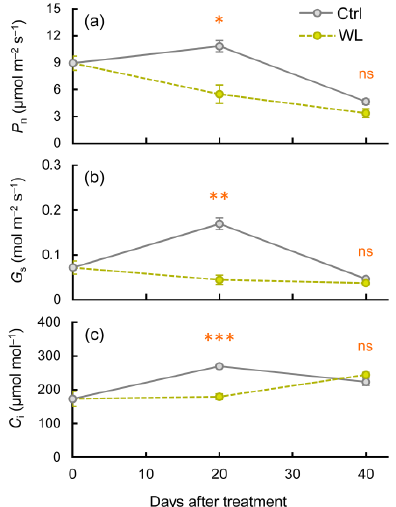
Figure 5. Changes in photosynthetic traits under control (Ctrl) and waterlogged (WL) soil conditions. ( a ) Net photosynthetic rate ( P n ), ( b ) stomatal conductance ( G s ), and ( c ) intercellular CO 2 concentration ( C i ). Values are the means ± S.E. of three to five replications derived from different plants. * p < 0.05, ** p < 0.01, *** p < 0.001; ns, not significantly different (Student’s t -test).